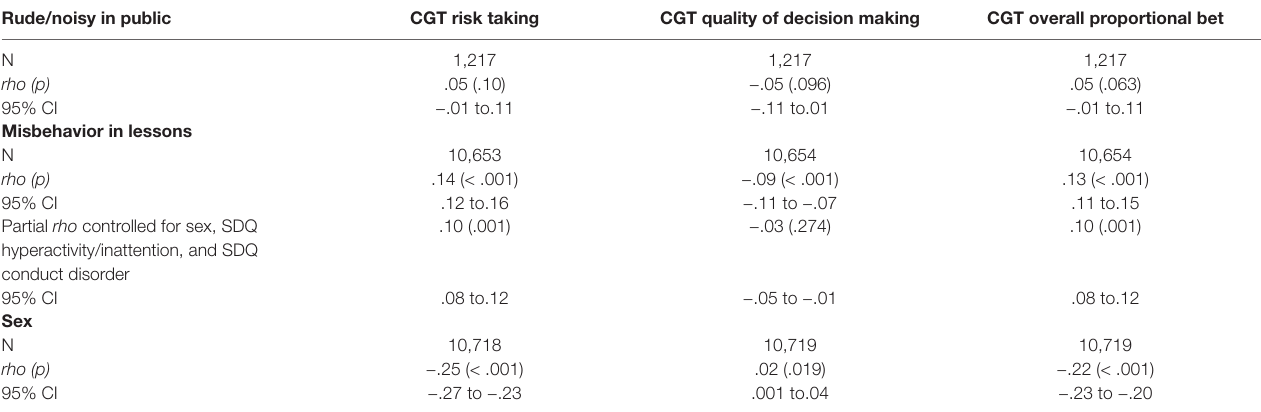
TABLE 2 | Association between NOSI indicators and CGT subscales.